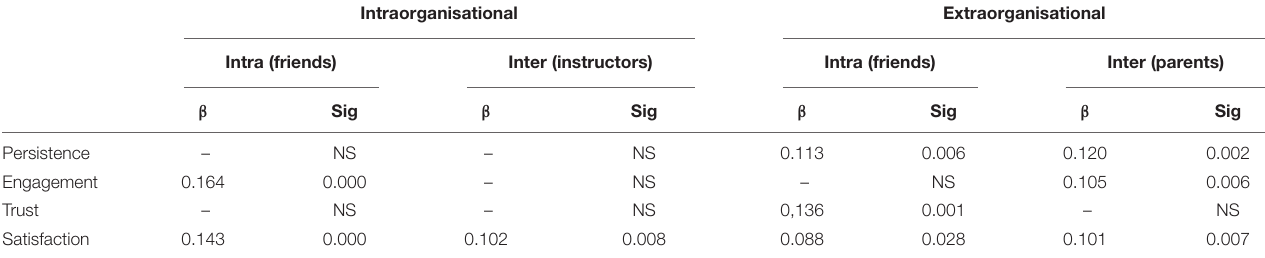
TABLE 2 | Connections of changing student’s relationship with changing achievement predictors ( N =